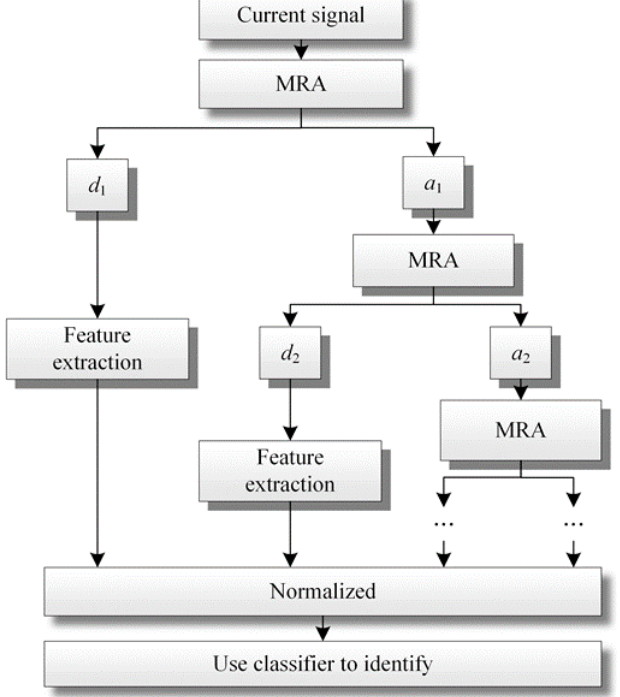
Figure 11. The feature extraction process of MRA.